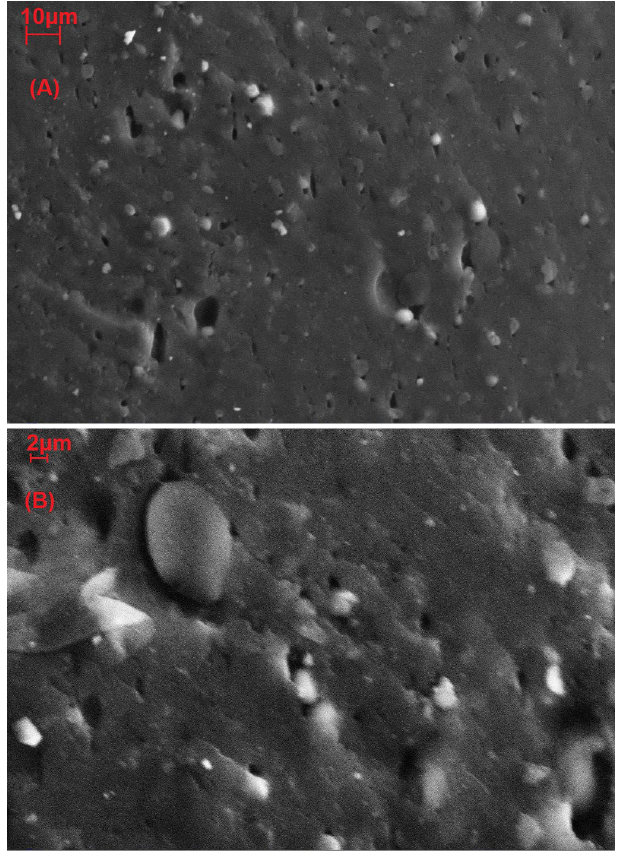
Figure 6. Scanning electron microscope image of wheat gluten plasticized with 35% of 1,4-butanediol and 10 php of microalgal biomass, magnifications 2000× ( A ) and 5000× ( B ).